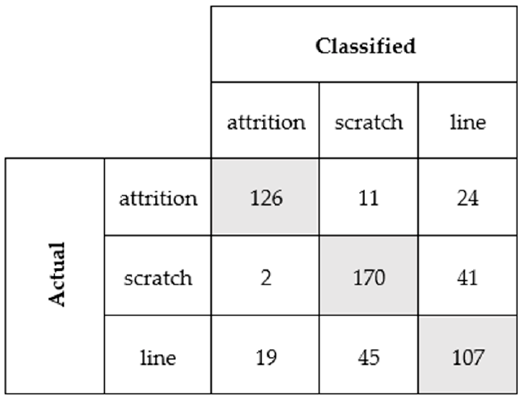
Figure 8. Confusion matrix of the model built using random forest.